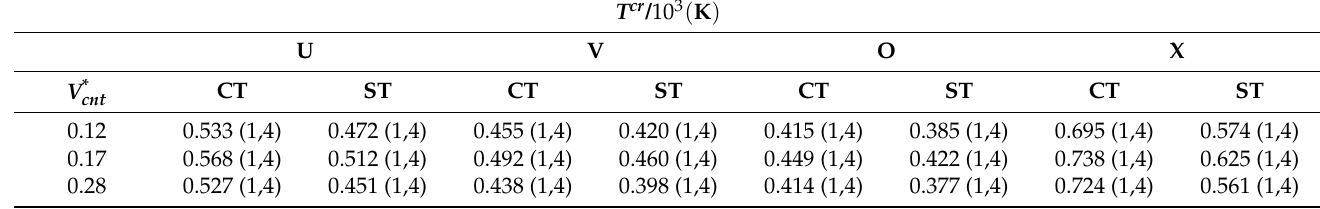
Table 2. Variation of CUT for nanocomposite cylindrical shells with different volume fractions.